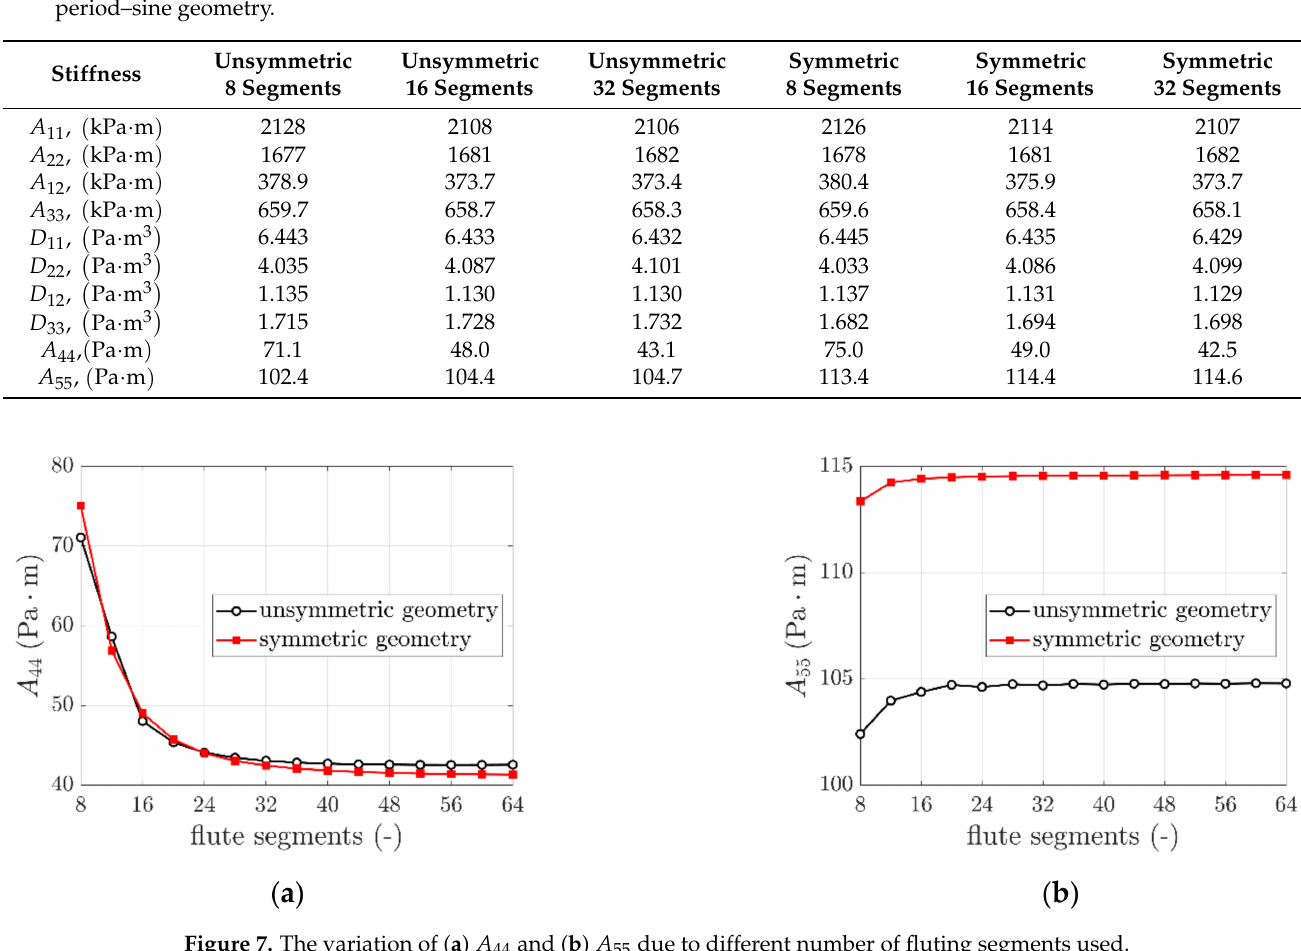
Figure 7. The variation of ( a ) A 44 and ( b ) A 55 due to different number of fluting segments